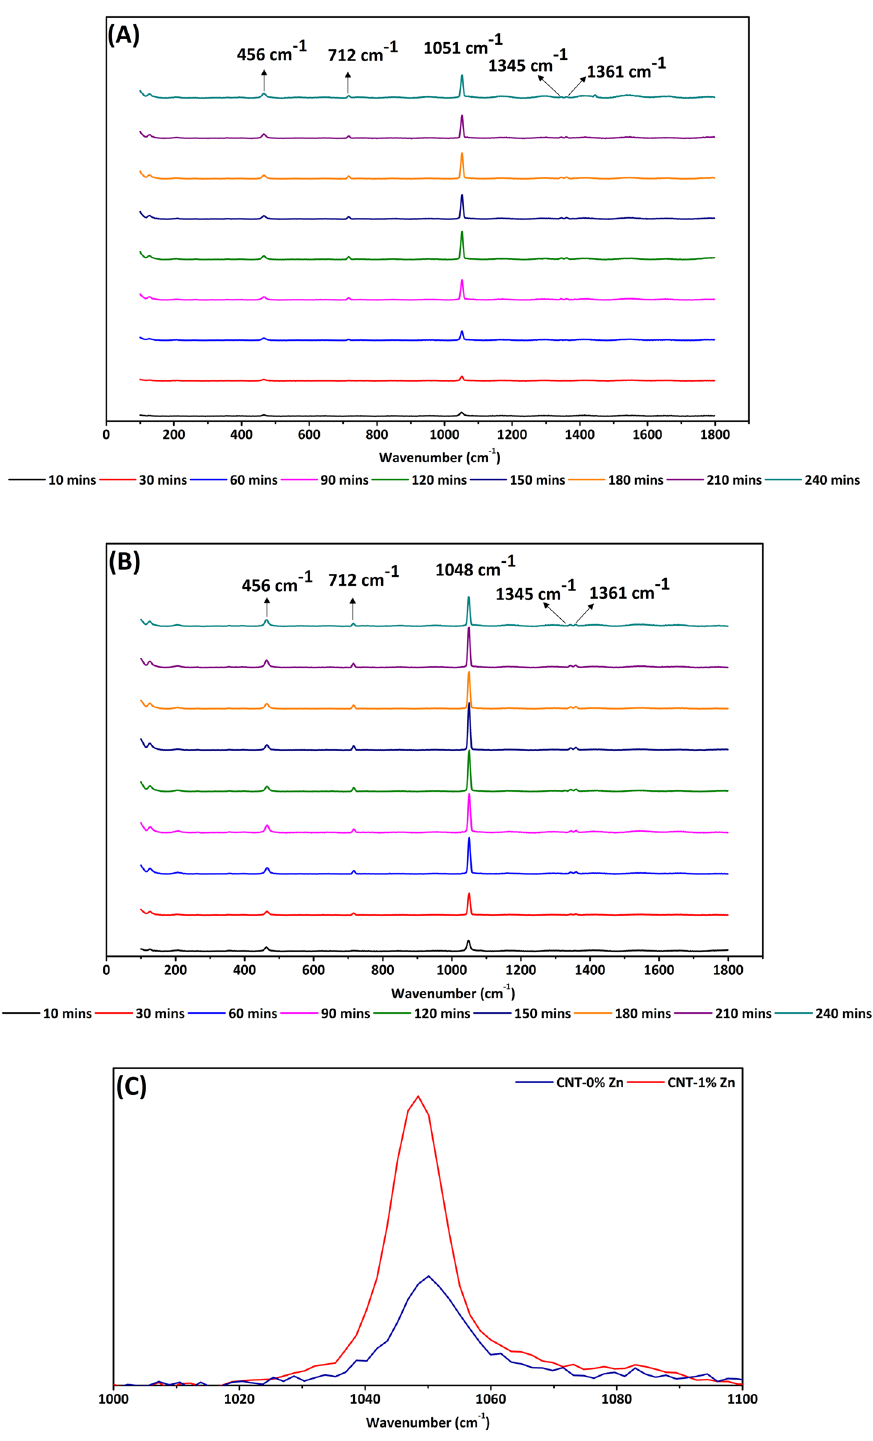
Figure 3. ( A ) Raman spectra of CNT-0%Zn; ( B ) Raman spectra of CNT-0%Zn; ( C ) Overlay of Raman spectra from geopolymer pastes having CNT-0%Zn and CNT-1%Zn (t = 10